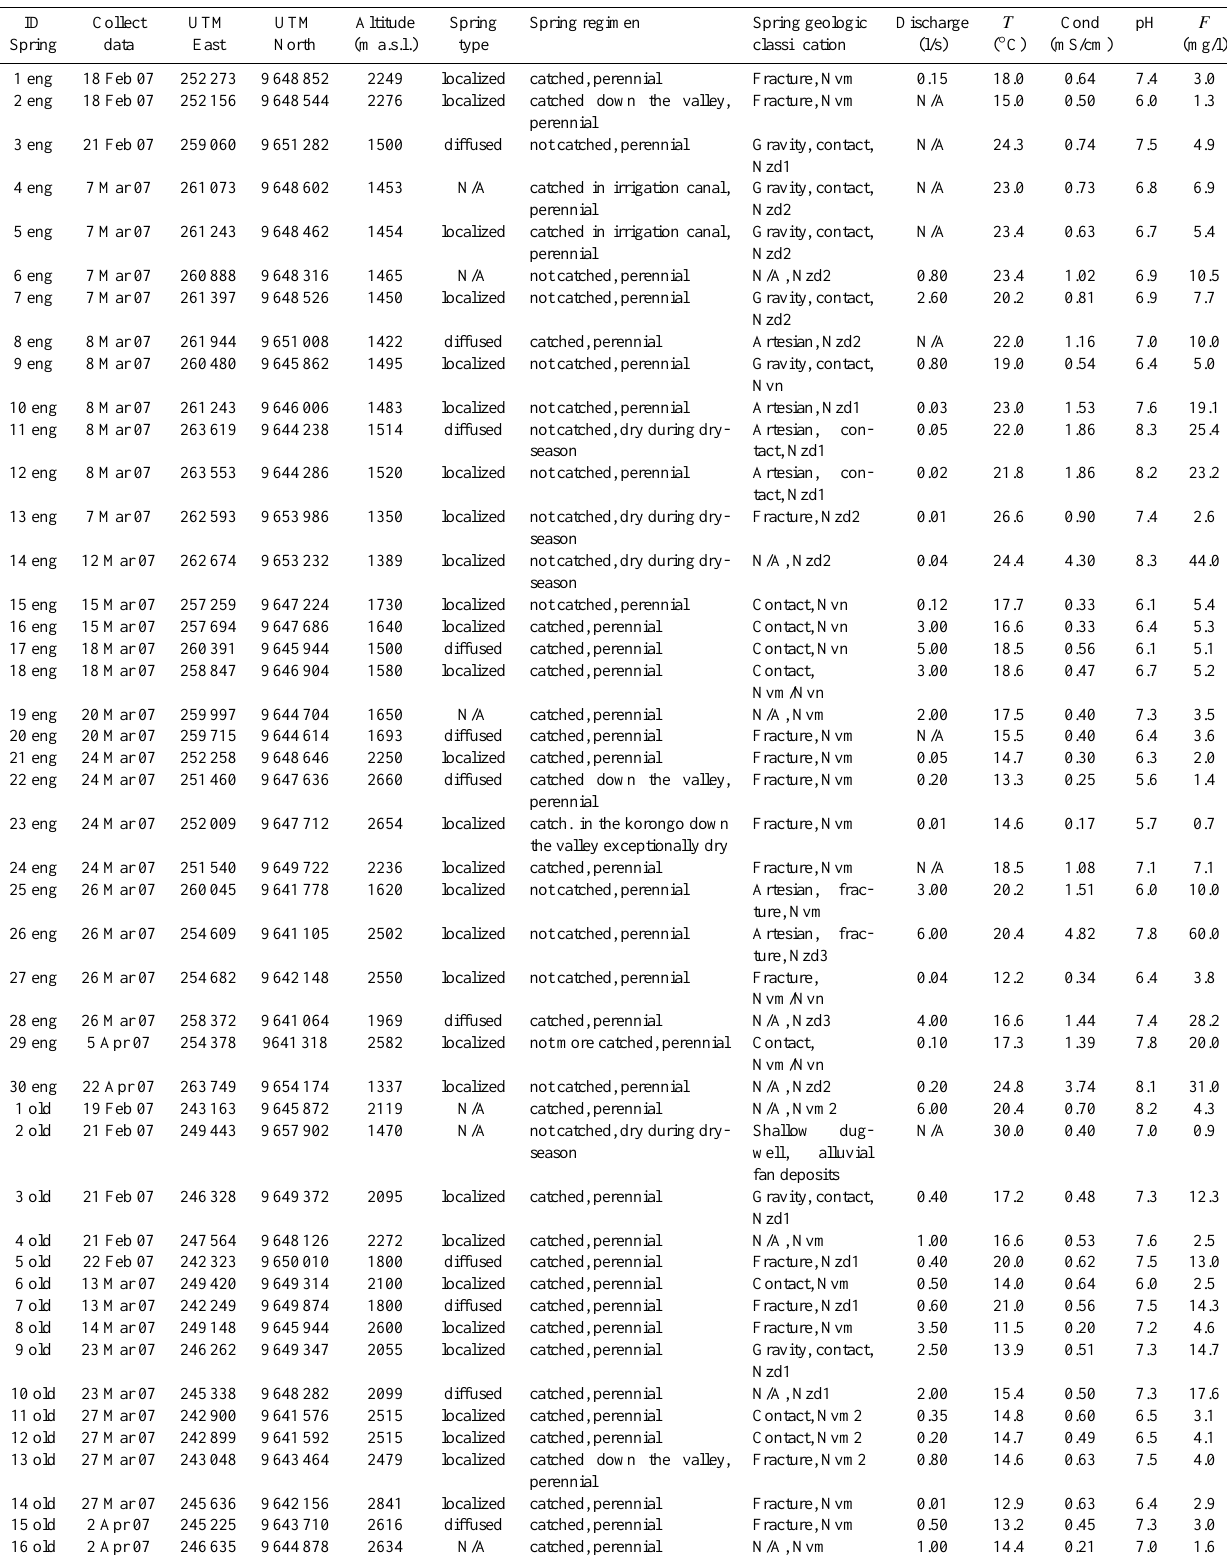
Table 1. Summary of springs